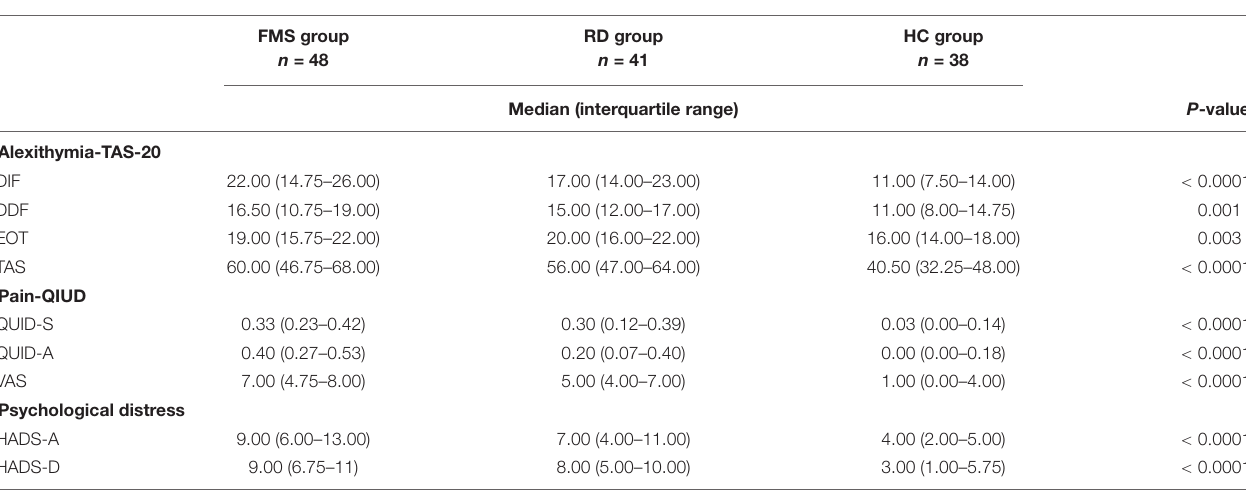
TABLE 2 | Questionnaire scales and subscales